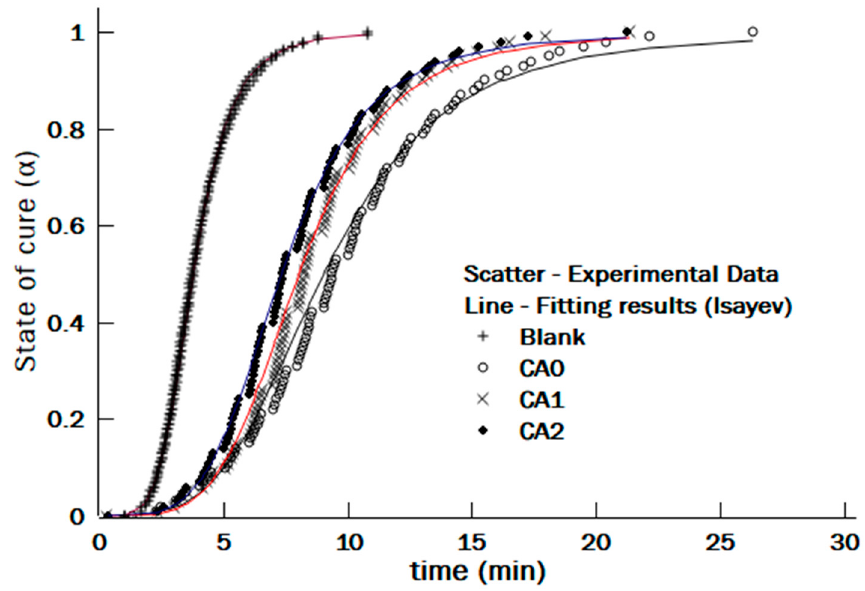
Figure 15. The fitting curves to calculate the state of cure for different NR-g-St loadings at 150 °C.